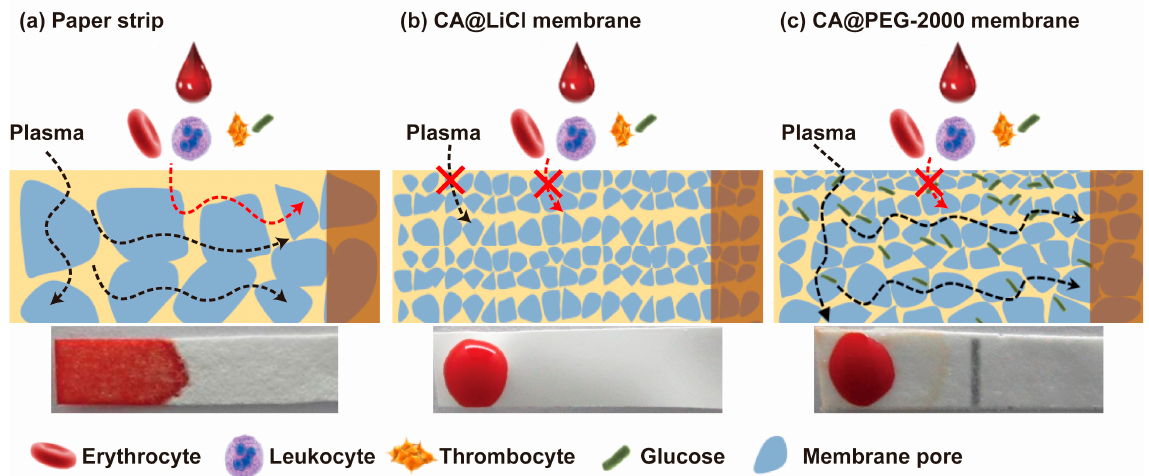
Scheme 1. The schematic diagrams of different membranes and bioassay